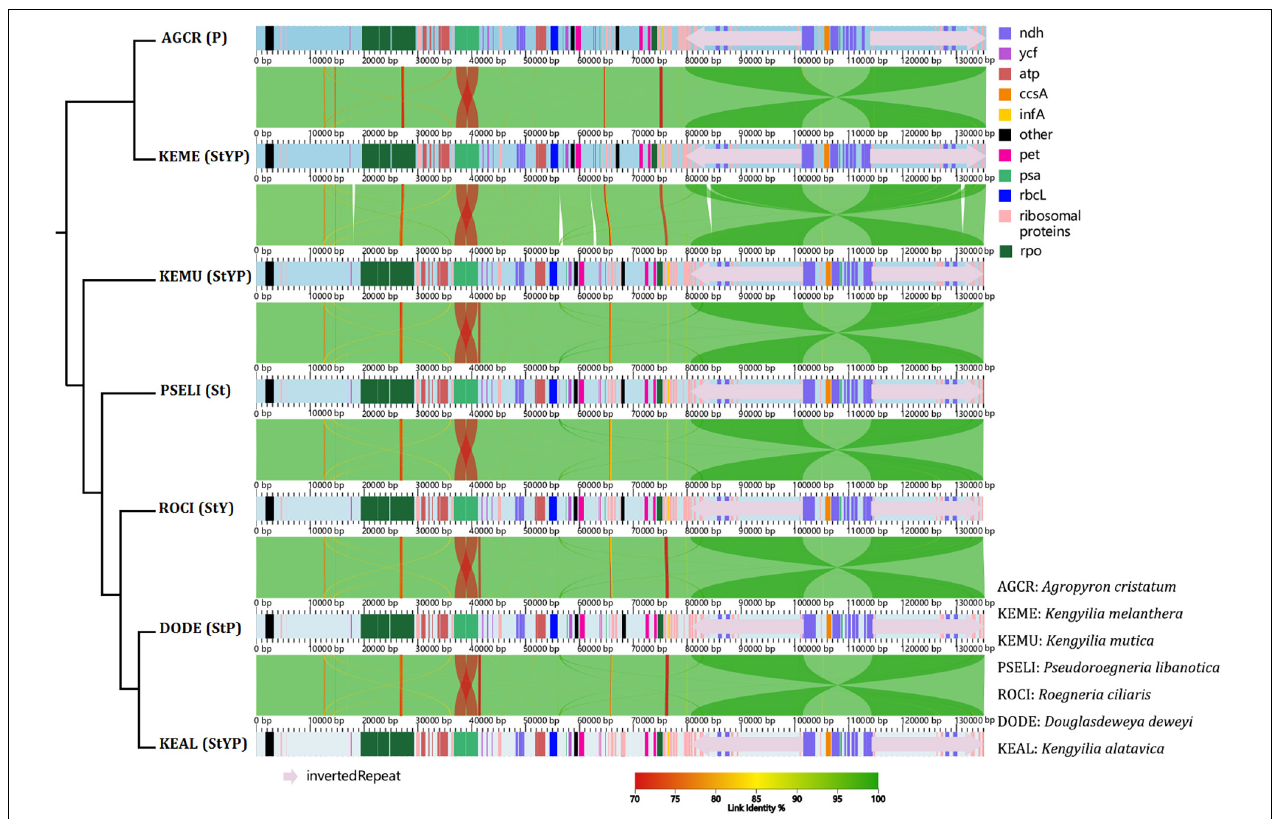
FIGURE 1 | The co-linear analysis of the chloroplast genomes of Kengyilia species and its close relatives. The phylogenetic tree was constructed based on the complete chloroplast genomes using ML.